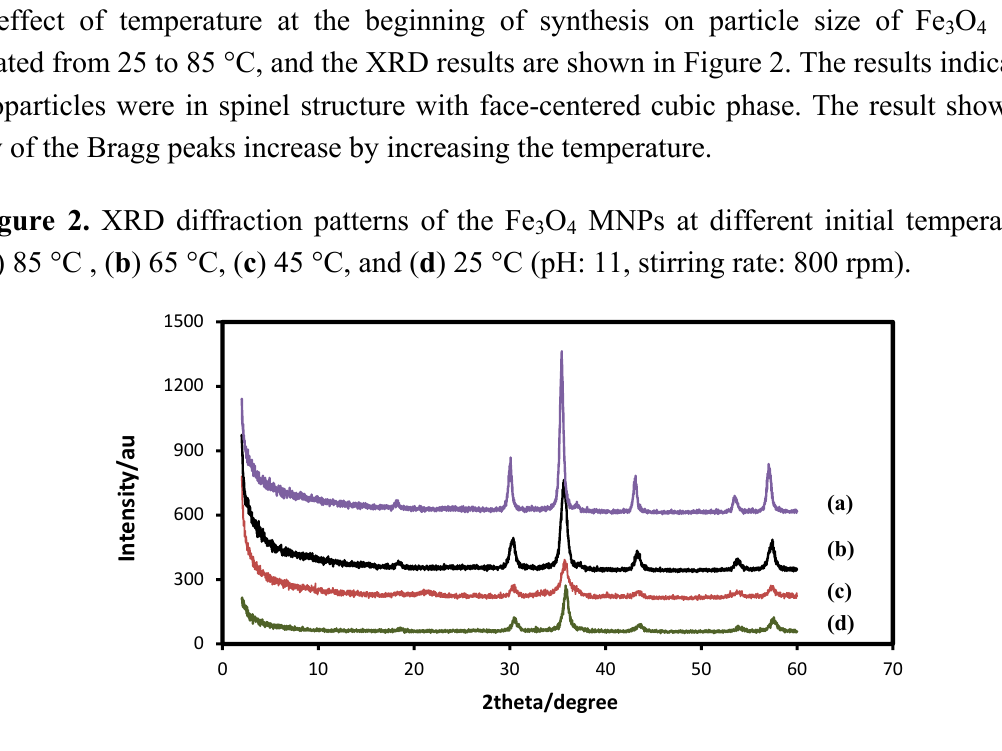
Figure 2. XRD diffraction patterns of the Fe